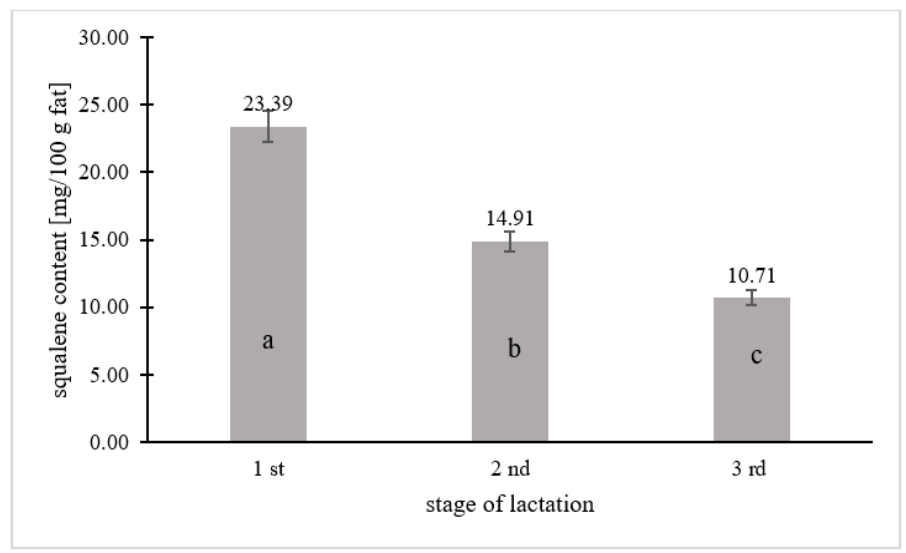
Figure 2. Squalene content in breast milk in relation to the lactation period. Means followed by a different letter (a, b, c) are significantly different ( p < 0.05).